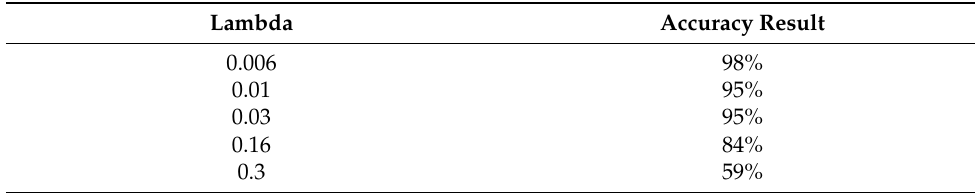
Table 4. Comparative table of different lambda values and relative accuracy